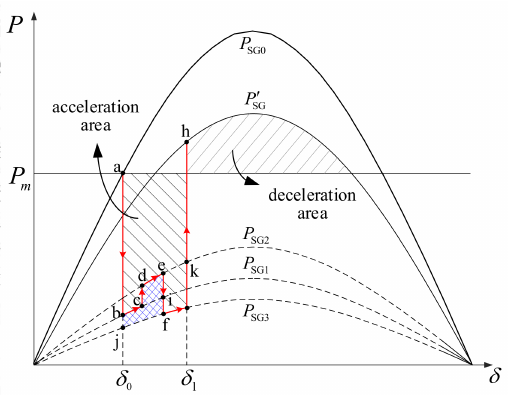
Figure 3. Rotor angle characteristics of synchronous generator (SG) with the influence of doubly fed induction generators